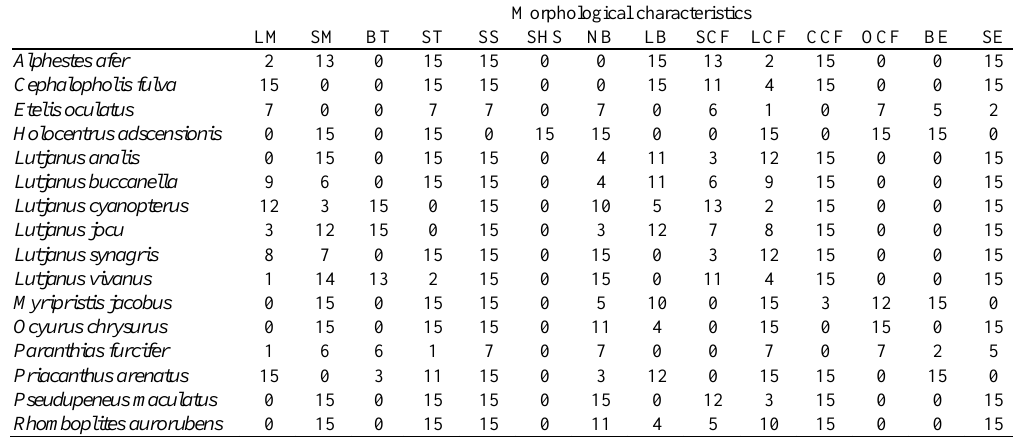
Table 2. Main morphological characteristics mentioned by fishermen to classify the integrants of the snapper group with the respective number of obtained answers (number of interviews = 15; for the E . oculatus and P . furcifer n = 7). LM = large mouth, SM = small mouth, BT = big teeth, ST = small teeth, SS = smooth scales, SHS = sharp scales, NB = narrow body, LB = large body, SCF = short caudal fin, LCF = long caudal fin, CCF = “closed” caudal fin, OCF = “open” caudal fin, BE = big eye, SE = small eye.